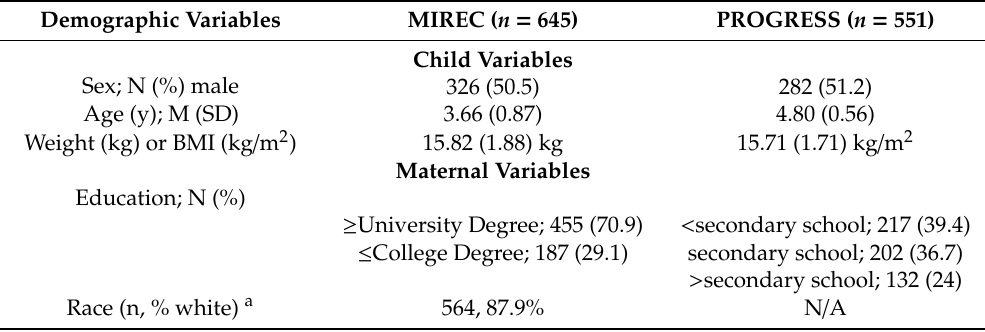
Table 1. Demographic characteristics of children with child urinary fluoride data.